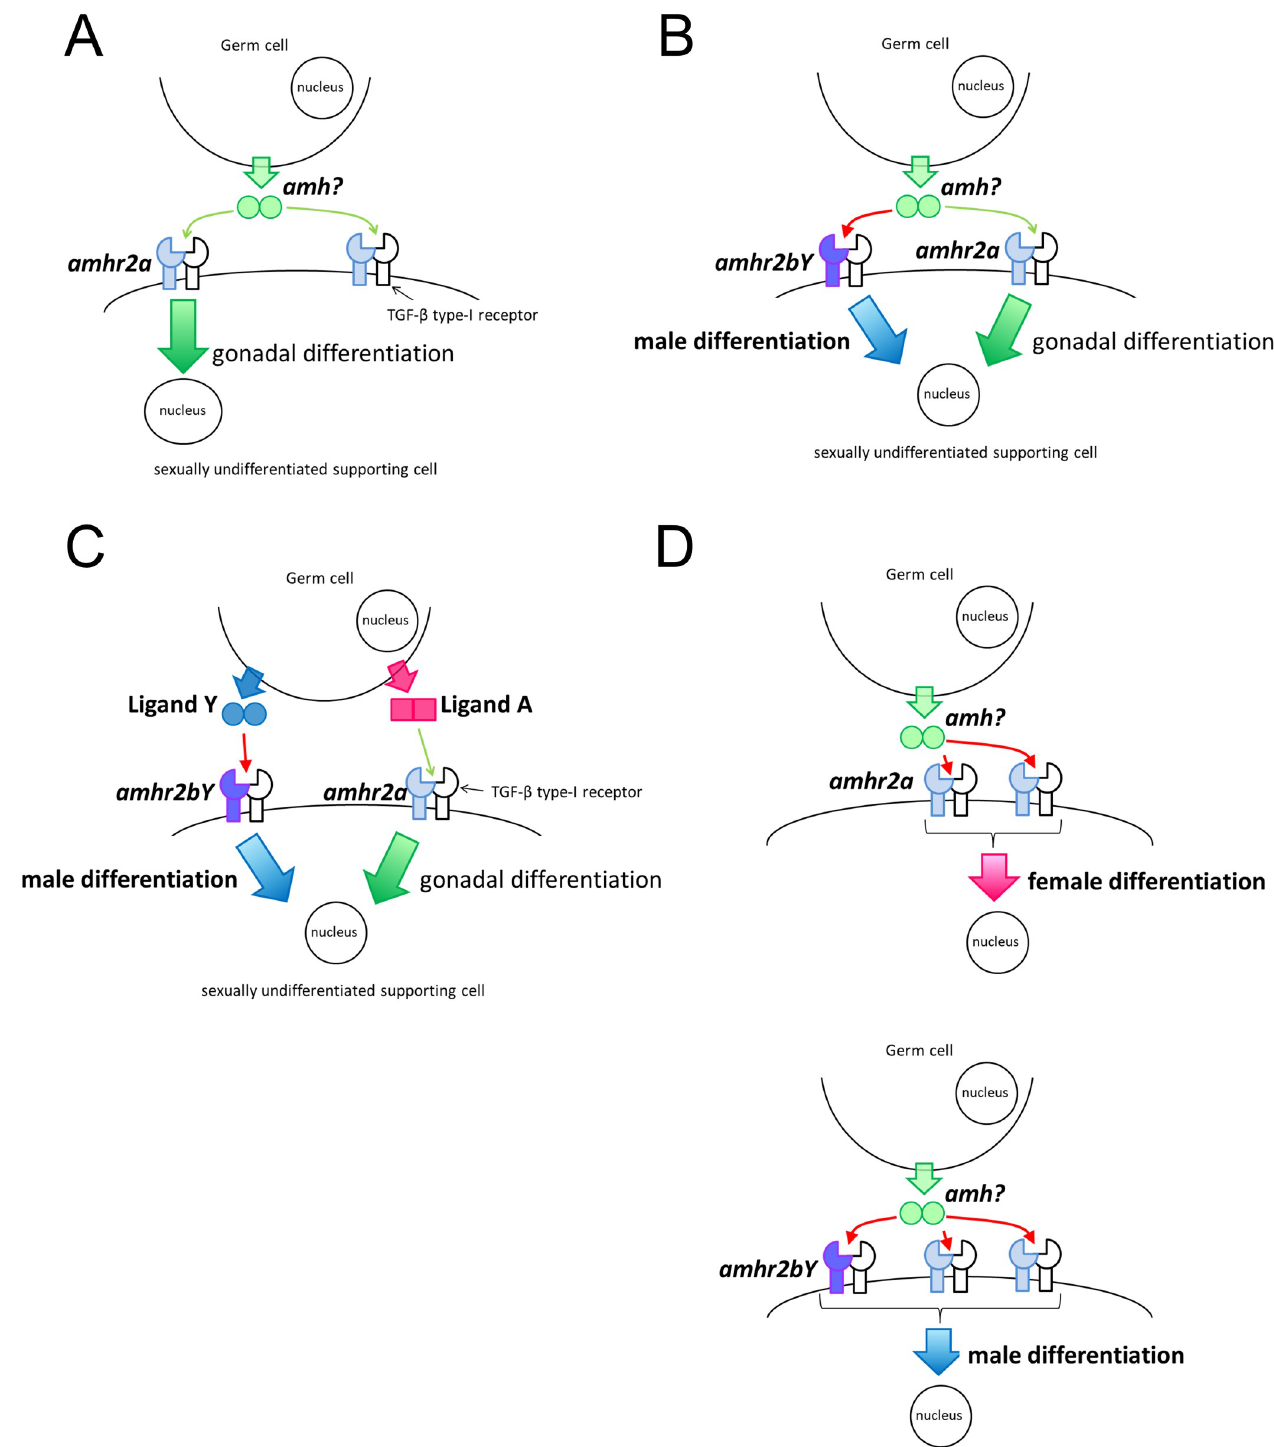
Fig 9. Summary diagram of gonadal sex determination in ayu. (A) Autosomal Amhr2a is located in supporting cells surrounding germ cells in sexually undifferentiated gonads. Putative ligand Amh is secreted from germ cells and supporting cells. amh/amhr2 signaling plays a role in germ cell–supporting cell interaction. (B) Hypothesis that Amhr2bY and Amhr2a have different signaling pathways. The same ligand binds to both Amhr2bY and Amhr2a. Amhr2bY initiates testicular development via a male-specific signaling pathway in sexually undifferentiated supporting cells surrounding germ cells. (C) Hypothesis that different ligands bind to Amhr2bY and Amhr2a. Amhr2bY binds to amhr2bY-specific ligand (ligand Y). Amhr2bY is activated by a specific ligand and initiates